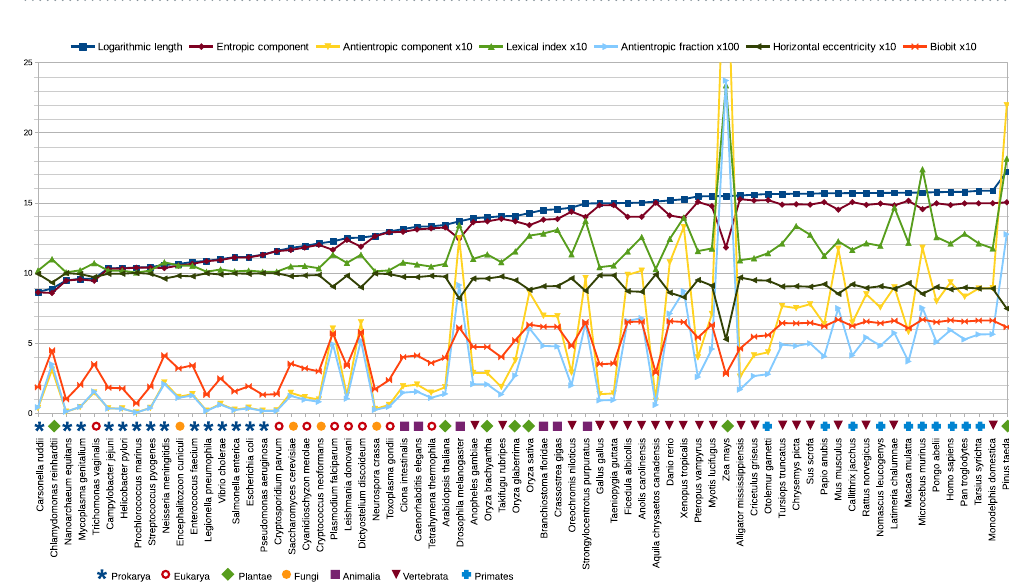
Figure 3. A chart of the main informational indexes. Some measures have been rescaled, by applying a factor of ten ( × 10) or one hundred ( × 100) to their value, to obtain a comprehensive overview. Species are arranged on the horizontal axis according to their genome length (increasing from left to